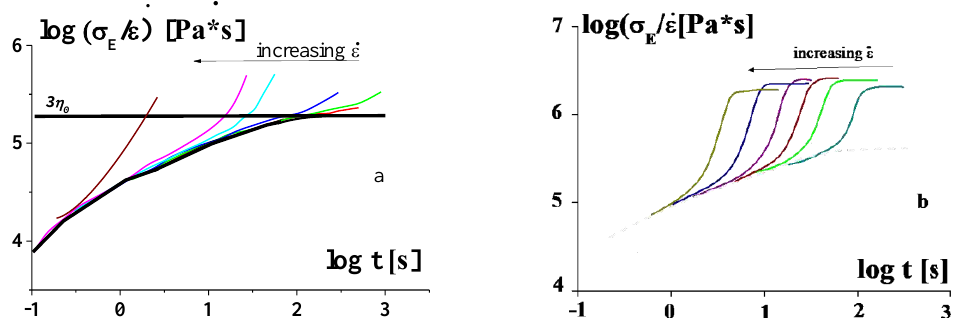
Figure 30. Typical examples of the rheological behavior of polymeric liquids (melts and solutions) in uniaxial extension (explanations are in the text).